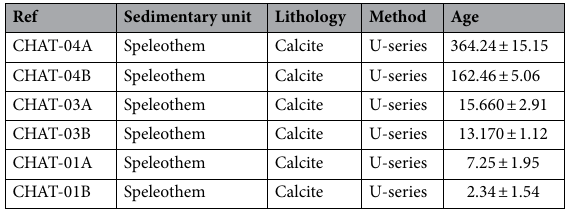
Table 1. U-series ages. All ages are given in ka, with a 2 σ